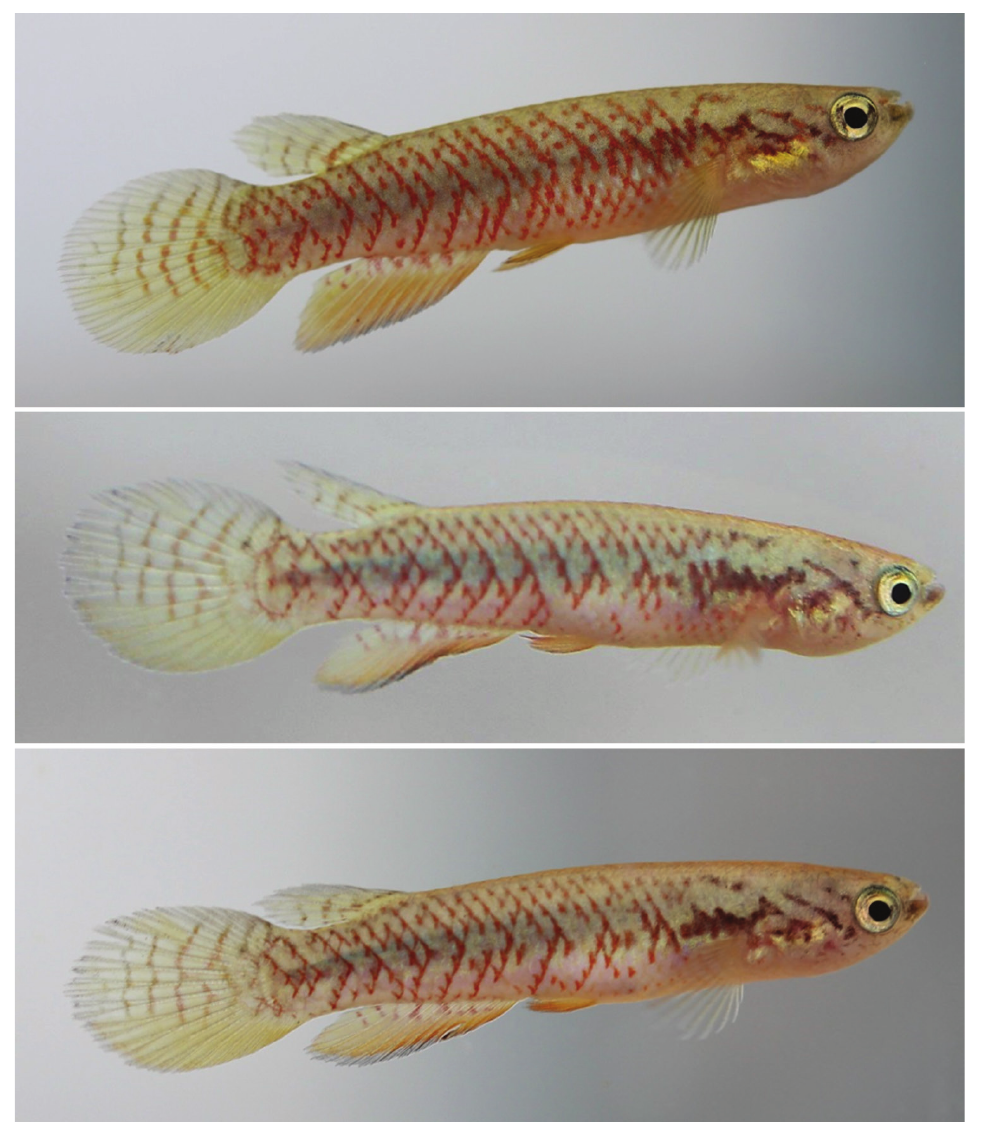
Figure 8. Colour pattern variation of male paratypes of M. amambaiensis sp. n., MCP 53151, small stream tributary of Rio Amam- baí, Mato Grosso do Sul